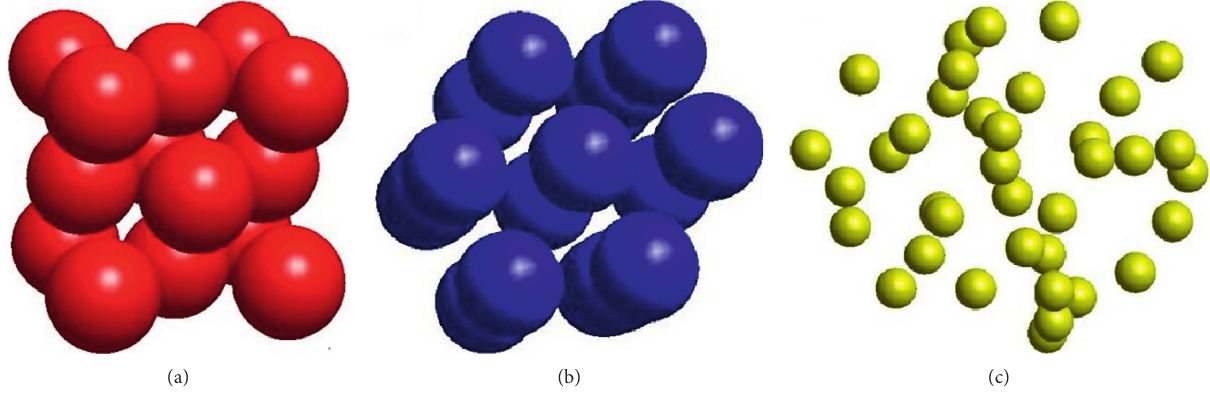
Figure 3: The shape of FCC (a), HCP (b), and Amor (c) structures in bulk Al.